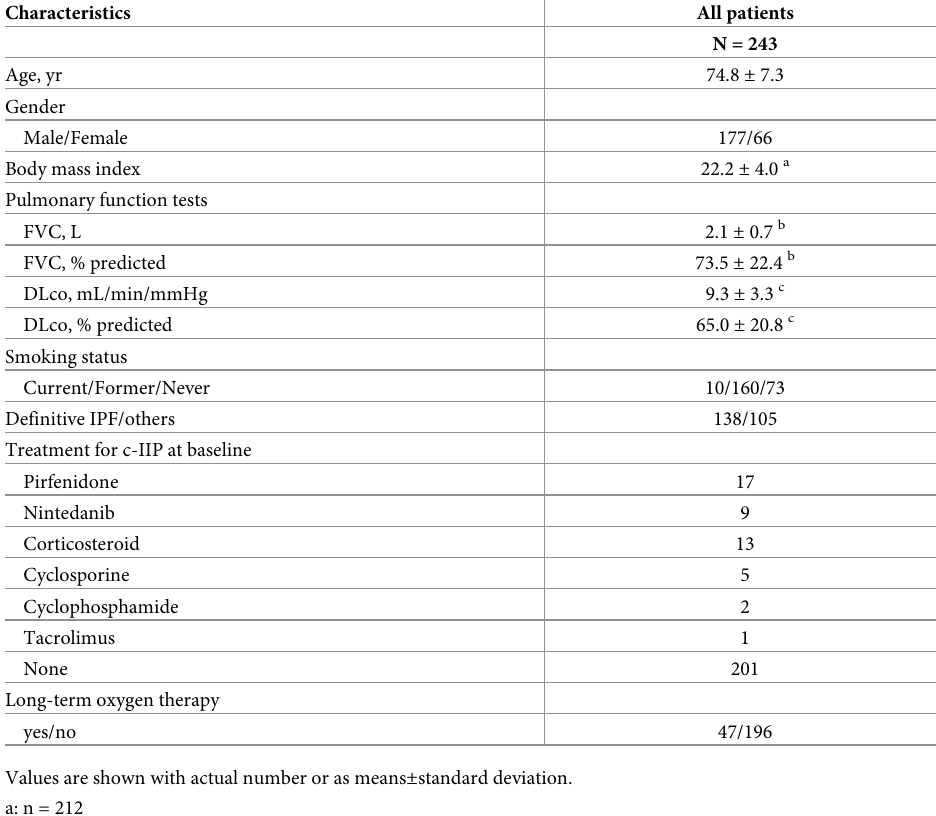
Table 1. Baseline characteristics of patients before the first